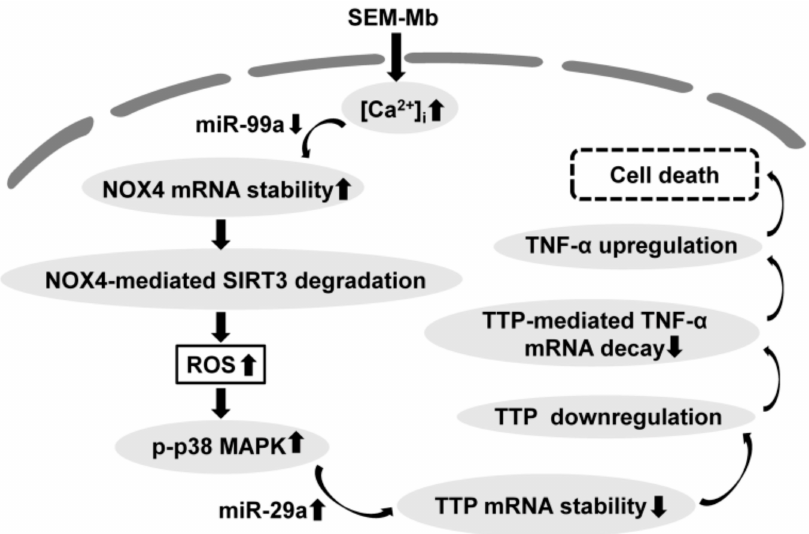
Figure 8. SEM-Mb induced TNF- α -mediated cell death signaling in U937 and HL-60 cells. SEM-Mb induces Ca 2+ -mediated miR-99a downregulation, leading to upregulate NOX4 expression in U937 cells. NOX4-induced SIRT3 degradation promotes mitochondrial ROS generation, which in turn elicits p38 MAPK-mediated miR-29a expression, thereby inhibiting TTP expression. Because TTP destabilizes TNF- α mRNA, SEM-Mb-induced TTP downregulation increases TNF- α expression. SEM- Mb treatment also induces TNF- α upregulation in HL-60 cells through the Ca 2+ /NOX4/SIRT3/p38 MAPK/TTP axis. Consequently, SEM-Mb-induced TNF- α upregulation triggers apoptosis in U937 and HL-60